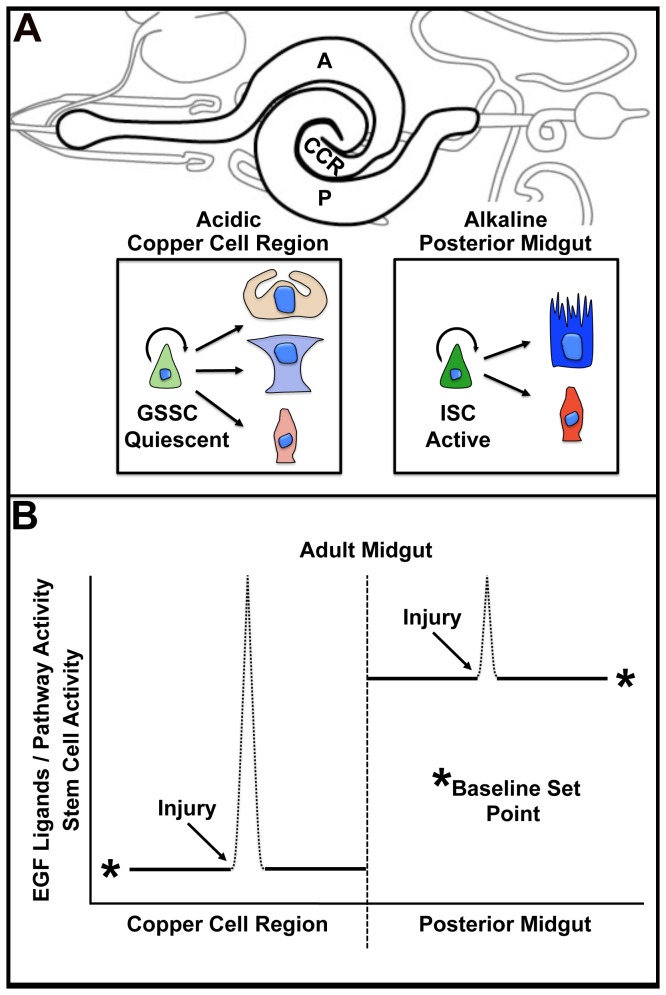
Regional control of gut stem cell proliferation.(A) Schematic diagram of the adult Drosophila midgut (bold). The gut can be divided into physiologically distinct regions; anterior (A), copper cell (CCR) and posterior (P). Gastric stem cells (GSSCs) in the acidic CCR differ from intestinal stem cells (ISCs) in the alkaline posterior midgut in two ways. First, GSSCs are tripotent and maintain three unique cells types in the lineage: acid-secreting copper cells (orange), interstitial cells (blue), and enteroendocrine cells (red). ISCs are bipotent and produce enterocytes (dark blue) and enteroendocrine cells (dark red). Second, GSSCs are quiescent compared to the more actively proliferating ISCs. (B) A model explaining the regional difference in gut stem cell proliferation. Gastric stem cells of the CCR are controlled by region specific modification of a core niche program. Under baseline conditions, EGF signaling and stem cell activity are low in the copper cell region and high in the posterior midgut. Injury induces EGF ligands and activates stem cells to divide.